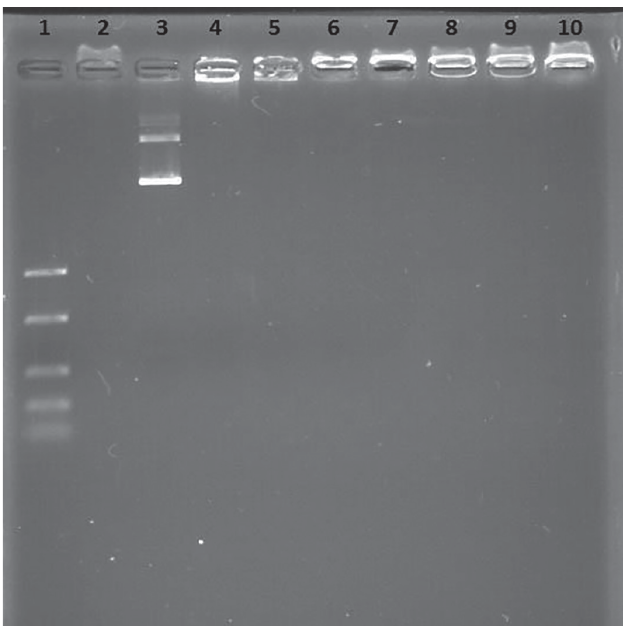
FIGURE 1 - Pseudo ternary phase diagram obtained with peceol, plurol oleique, T80 and ethanol. S/Cos ratio: (1:1). Grey area represents W/O microemulsion formation area. Black dot represents the selected W/O microemulsion